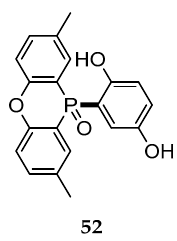
Figure 24. Phosphine oxide derivative 52 .